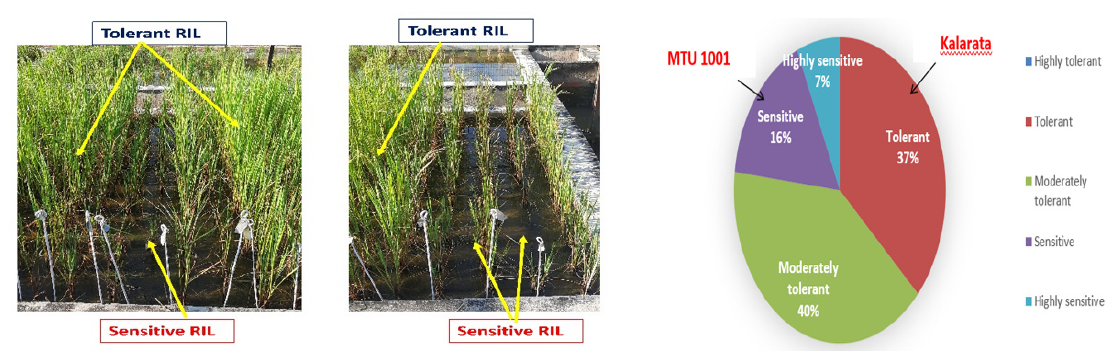
Figure 1. Response of RIL population in alkaline stress conditions.